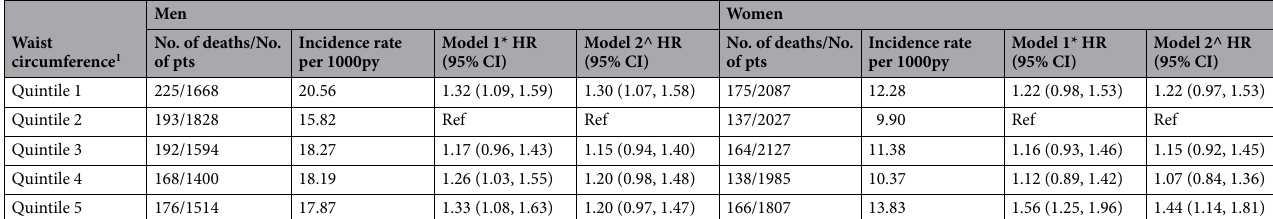
Table 3. Hazard ratio (95% CI) of all-cause mortality according to baseline waist circumference in men and women (n = 18,037). 1 Waist circumference Quintile Range (Mean) values for Men (cm): Q1: 56–93 (88.13); Q2: 94–99 (96.67), Q3:100–104 (101.97), Q4:105–110 (107.31), Q5: 111–153 (118.15); Female: Q1: 44–82 (76.15), Q2: 83–89 (86.13), Q3: 90–96 (92.95), Q4: 97–104 (100.2), Q5: 105–180 (112.77). *Model 1: Adjusted for age. ^Model 2: Adjusted for age, smoking status, aspirin treatment arm, diabetes status (yes, no), level of education (< 12 years, ≥ 12 years), living status (at home alone, with others), alcohol consumption (current alcohol consumption, former/never), and longest amount of time walking outside home without any rest. py, person years; Ref., reference.